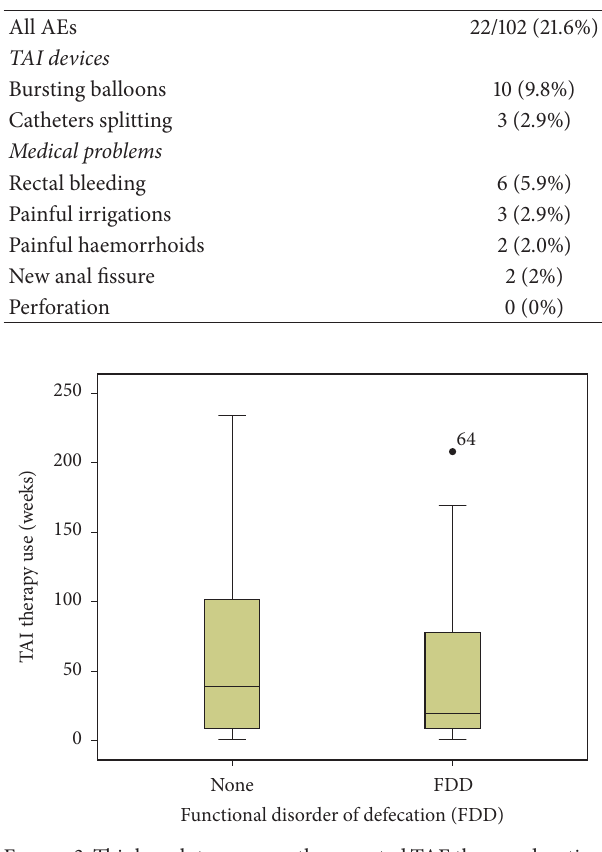
Figure 3: This boxplot compares the reported TAE therapy duration ( 𝑦 -axis, weeks) of patients classified from baseline proctograms as having a functional defecation disorder (FDD) [ 𝑁 = 40 , mean use = 45 weeks, SD = 49.5] and no FDD [ 𝑁 = 36 , mean use = 59 weeks, SD = 60.7], with no significant difference detected between these groups [ 𝑃 = 0.29